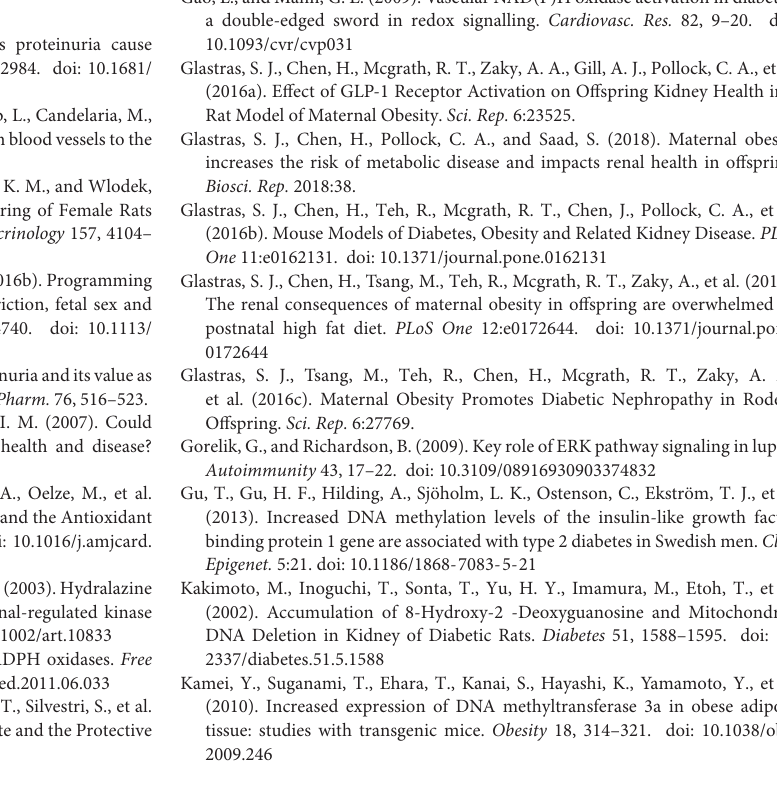
Supplementary Figure 2 | Renal structural changes. Representative image of picrosirius red staining of kidney cortex at 200 × magnification demonstrating tubulointerstitial fibrosis, tubular vacuolation, tubular dilatation, and